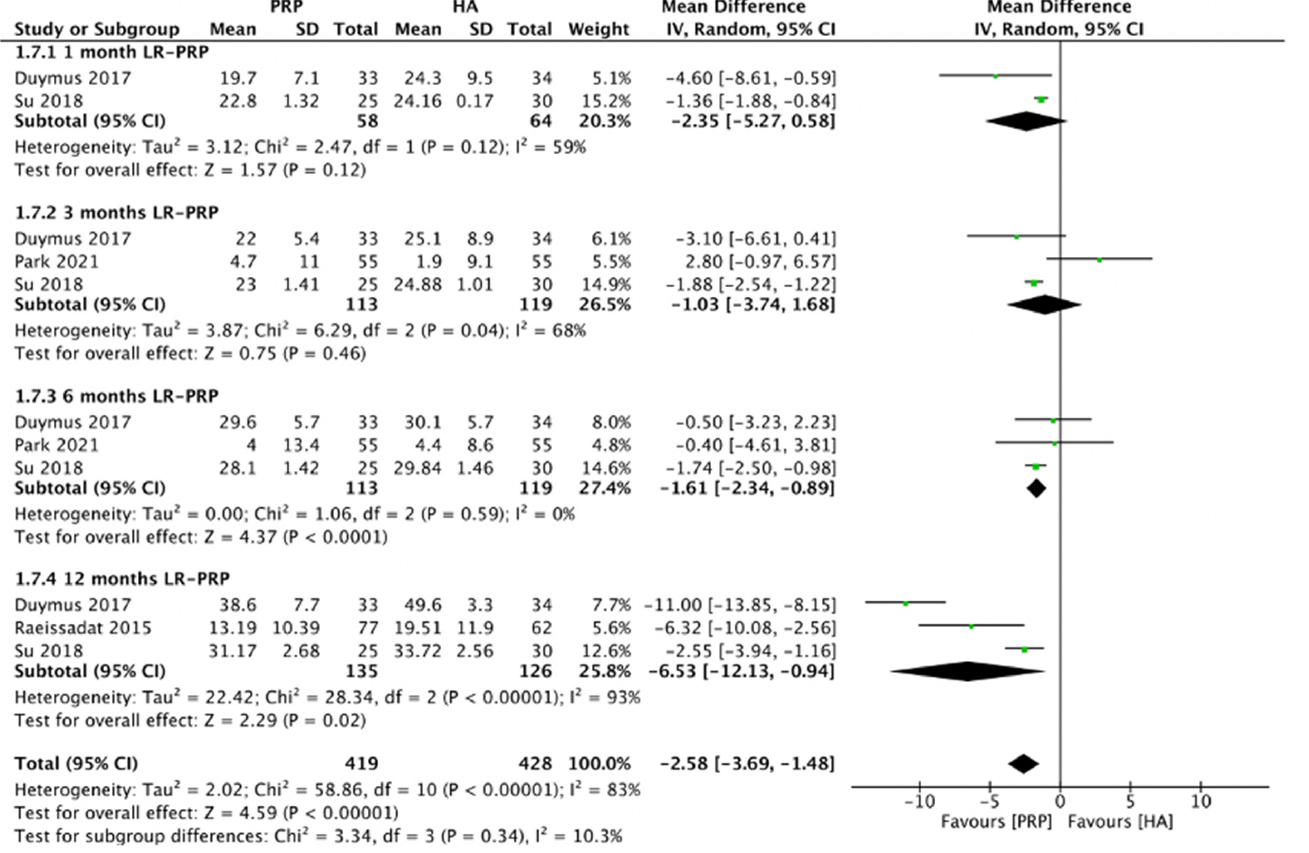
Figure 7. Trials of LR-PRP versus HA. Forest plot of WOMAC physical functional scores. (IV, inverse variance; CI, confidence interval; SD, standard deviation).